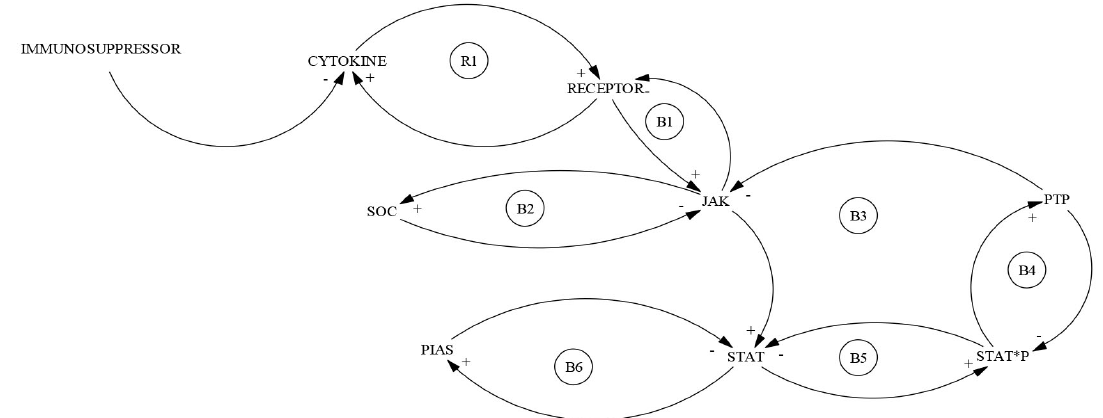
Figure 2. CLD representation of traffic shaping in COVID-19 by controlling JAK/STAT pathways. CLD description was based on current knowledge of regulation of JAK/STAT signaling pathways in the immune system, following Shuai and Liu [13]. It seems clear that the regulation of the JAK/STAT signaling pathway represents a high-level challenge since it involves at least six balanced sub-cycles (B1–B6), which makes the system quite robust, suggesting that intervening in them is a difficult task. Hence, therapies based on the use of immunosuppressants in COVID-19 must be applied under very careful clinical supervision Data